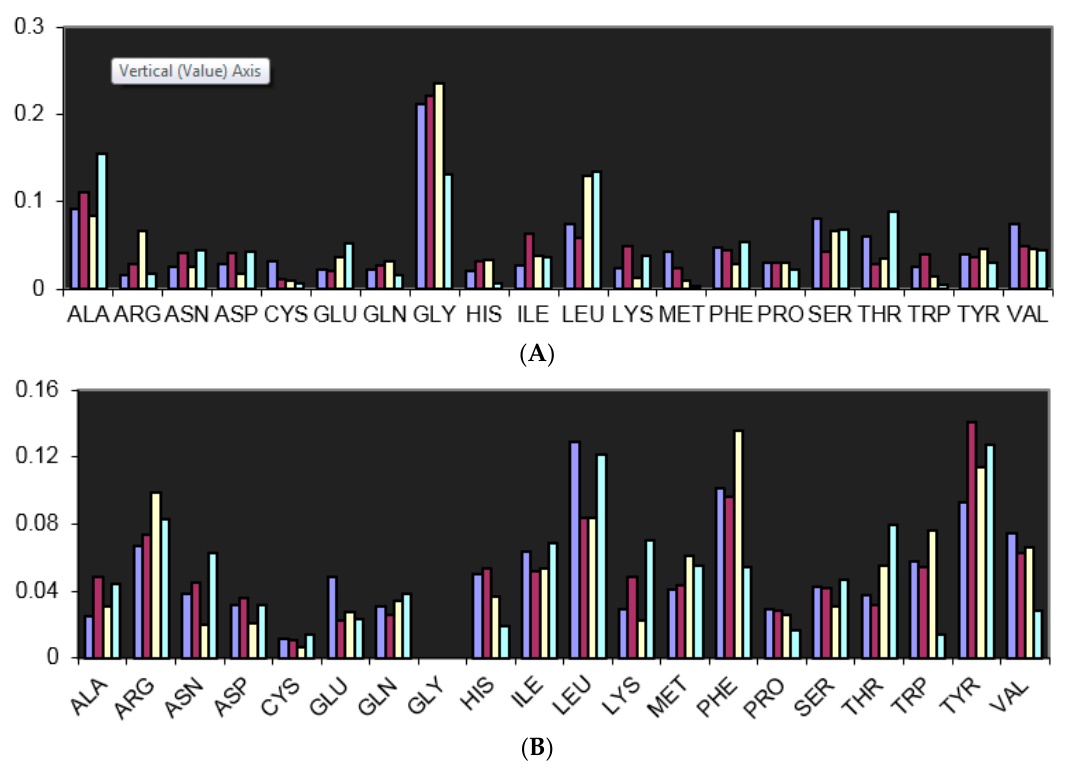
Figure 2. ( A ) Frequency of interactions of halogenated ligands with proteins. The interactions are defined using van der Waals radii between halogen of the ligand and backbone carbonyl or backbone nitrogen of the protein as Lewis bases. The interaction is labeled as being as above at the N-C α -C of the side chain that is pendant off of the backbone.The data is normalized to the maximum number of interactions made by each halogenated ligand; ( B ) Frequency of interactions of halogenated ligands with proteins. The interactions are defined using van der Waals radii between halogen of the ligand and side chain Lewis bases (oxygen, nitrogen, and sulfur). Also included are interactions as above with the π electron rich aromatics residues (Phe, Tyr, Trp and His). The data is normalized to the maximum number of interactions made by each halogenated ligand (the figure has been reproduced with permission from [39]).